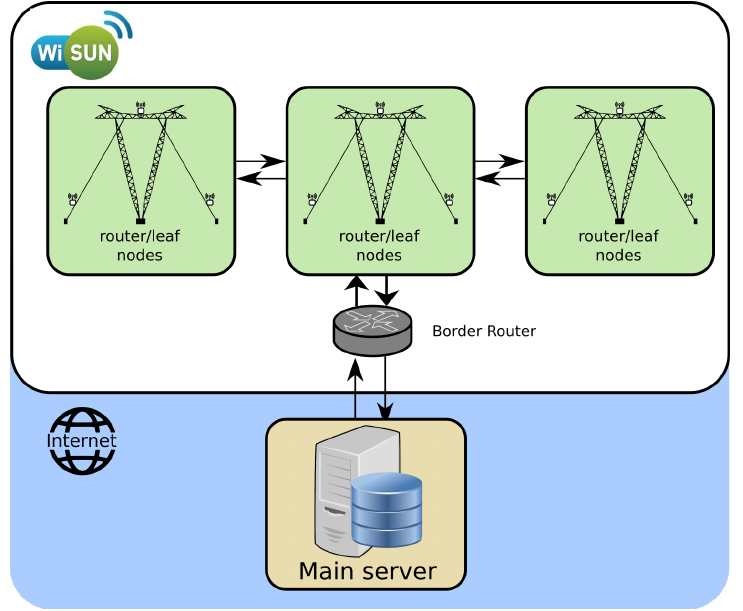
Figure 1. The overall solution